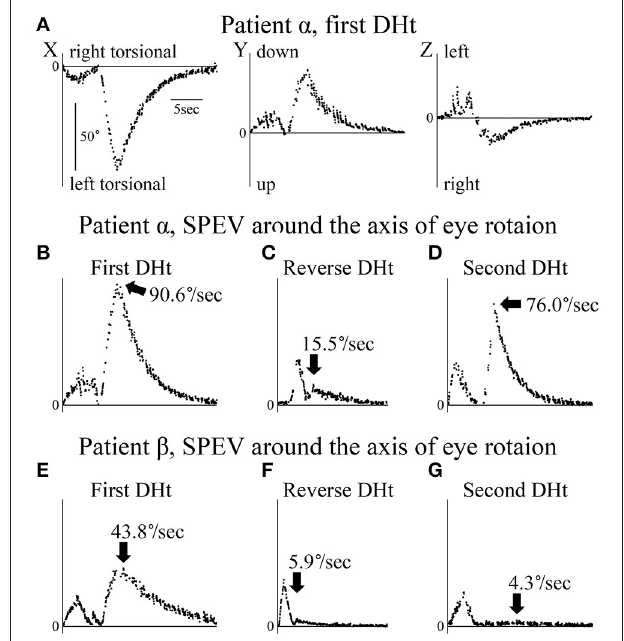
FIGURE 3 | Axis angles of the slow phase eye velocity (SPEV) of the positional nystagmus. DHt, Dix–Hallpike test. (A–D) Patient α allocated to group A. ( E–G ) Patient β allocated to group B. ( A ) 3D axis angle of the SPEV of the positional nystagmus induced by the first right Dix–Hallpike test. These data were calculated from the eye position data shown in Figure 2A . In the X and Y components, two peaks were observed. The first peak was caused by the VOR, while the second was caused by the positional nystagmus. After the second peak, the SPEVs in X, Y, and Z components were reduced; the SPEV became almost 0 after 16s. Thus, the positional nystagmus disappeared at 16s after the peak SPEV. ( B ) Axis angle of the SPEV of the positional nystagmus around the axis of the eye rotation induced by first right Dix–Hallpike test. This is the absolute value of the 3D vector of the axis angle of the SPEV of the positional nystagmus shown in Panel A . This value reflects the magnitude of the SPEV around the axis of eye rotation. Two peaks were observed. The first peak was caused by the VOR, while the second peak was caused by the positional nystagmus. The maximum SPEV (MSPEV) of the positional nystagmus was 90.6 ◦ /s. ( C ) Axis angle of the SPEV of the positional nystagmus around the axis of eye rotation induced by the reverse Dix–Hallpike test. These data were calculated from the eye position data shown in Figure 2B . The MSPEV of the positional nystagmus was 15.5 ◦ /s. (D) Axis angle of the SPEV of the positional nystagmus around the axis of eye rotation induced by the second right Dix–Hallpike test. These data were calculated from the eye position data shown in Figure 2C . The MSPEV of the positional nystagmus was 76.0 ◦ /s. (E) Axis angle of the SPEV of the positional nystagmus around the axis of eye rotation induced by the first left Dix–Hallpike test. The MSPEV of the positional nystagmus was 43.8 ◦ /s. (F) Axis angle of SPEV of the positional nystagmus around the axis of eye rotation induced by the reverse Dix–Hallpike test. The MSPEV of the positional nystagmus was 5.9 ◦ /s. (G) Axis angle of the SPEV of the positional nystagmus around the axis of eye rotation induced by the second left Dix–Hallpike test. These data were calculated from the eye position data shown in Figure 2D . The MSPEV of the positional nystagmus was 4.3 ◦ /s.